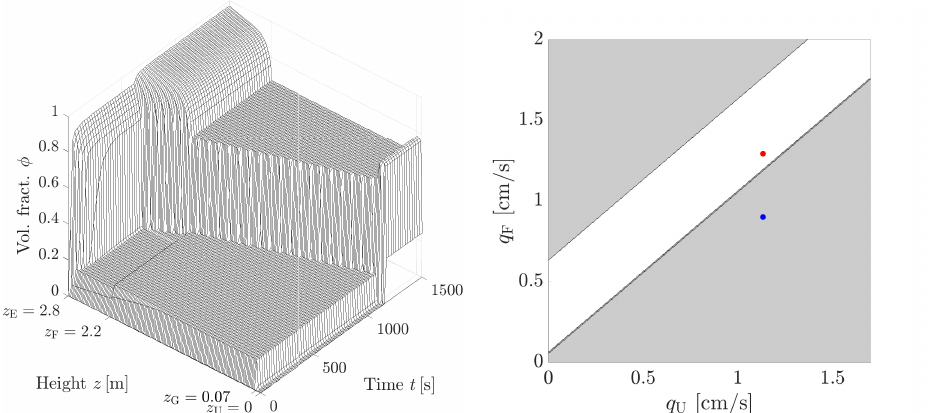
Figure 13. Dynamic simulation of a bubble–liquid flow. ( Left ) Time evolution of the volumetric fraction profile of loaded gas bubbles φ from t = 0s to t = 1500s. ( Right ) Theoretical operating chart for the simulation in Section 4.3.1. The point marked in red corresponds to ( q U , q F , q G , q W ) = ( 1.132,1.292,1.8,0 ) cm/s and the one in blue to ( q U , q F , q G , q W ) = ( 1.132,0.9,1.8,0 ) cm/s.